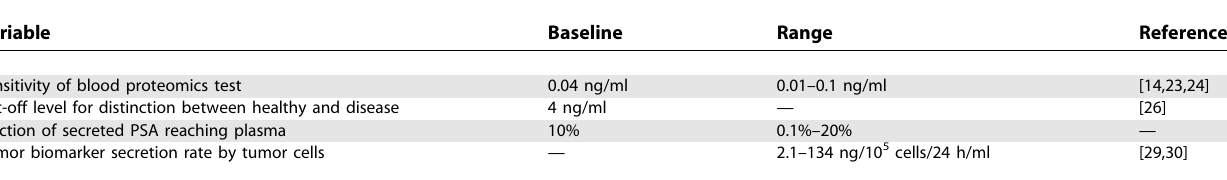
Table 4. Variables Used to Test the Tumor Biomarker Assay Model PSA Variable